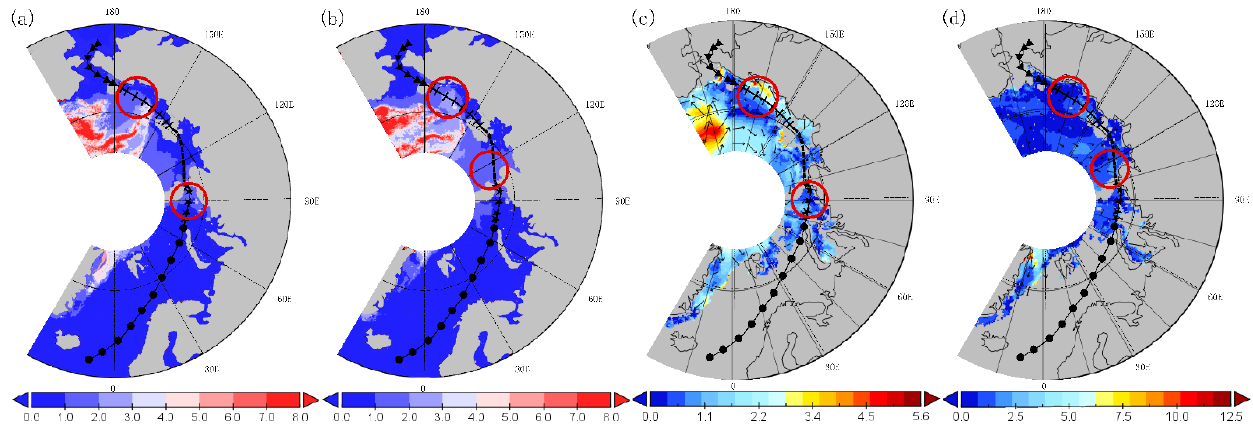
Figure 8. The distribution map of sea ice age in the NEP in the Arctic summer in 2000 ( a ) and 2001 ( b ), and the map of sea ice movement in the NEP in the Arctic summer in 2000 ( c ) and 2001 ( d ).